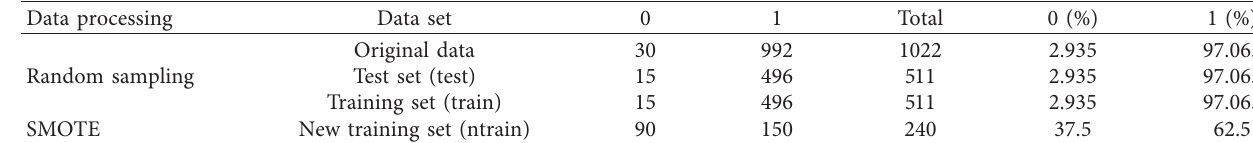
Table 2: Data composition.